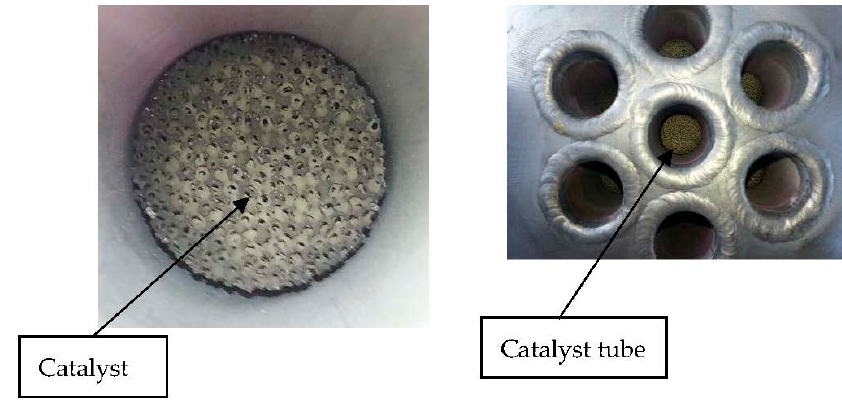
Figure 2. Catalyst arrangement in R-01 reactor.